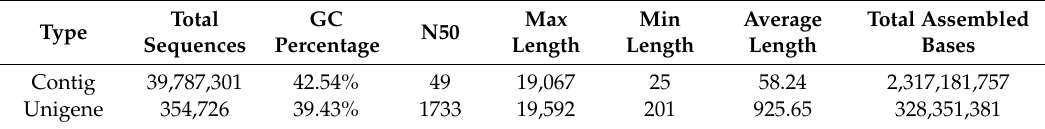
Table 2. Assembly statistics for Diaphorina citri transcriptomes across developmental